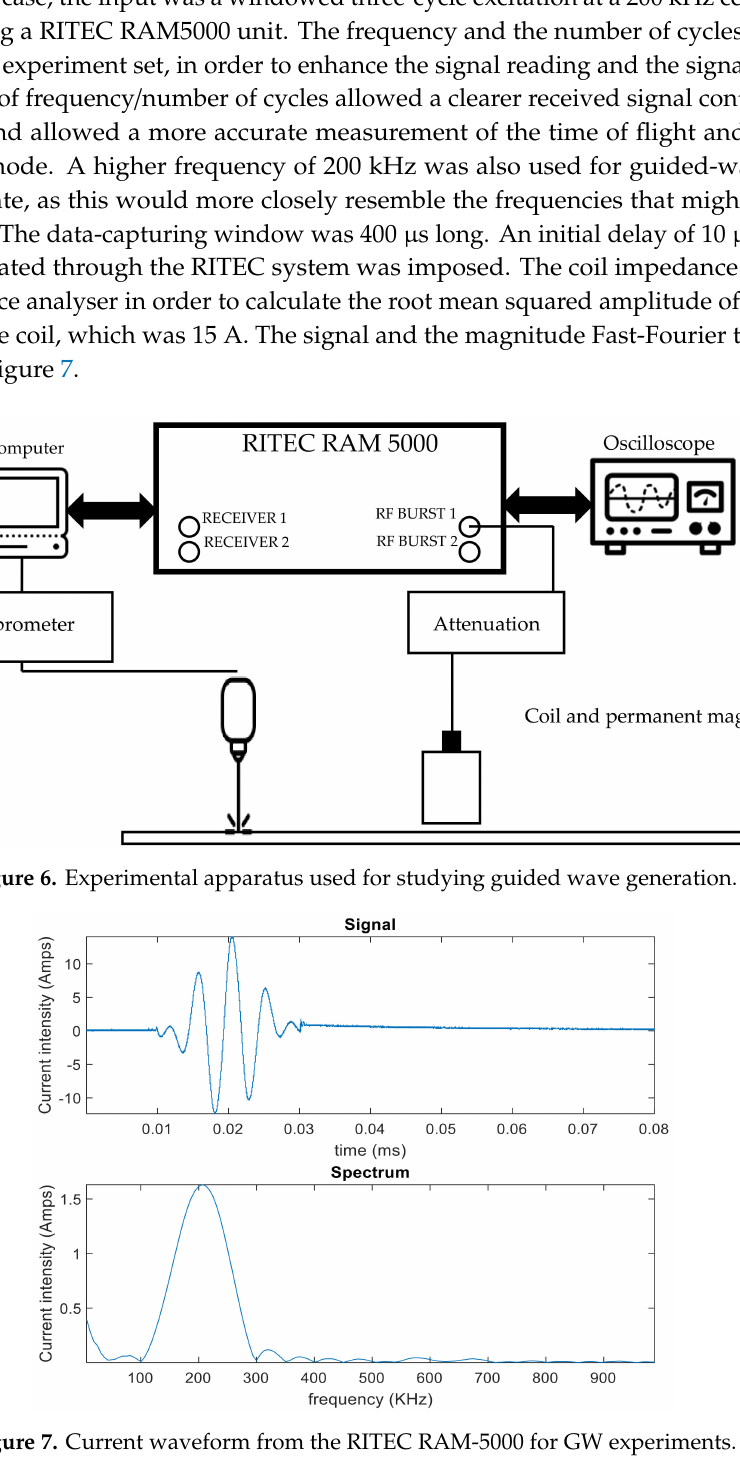
Figure 7. Current waveform from the RITEC RAM-5000 for GW